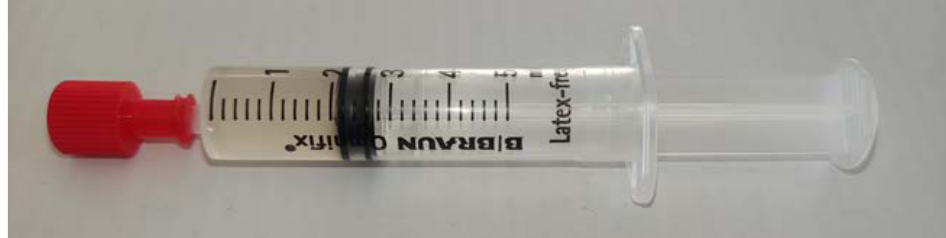
Figure 2. Single dose of